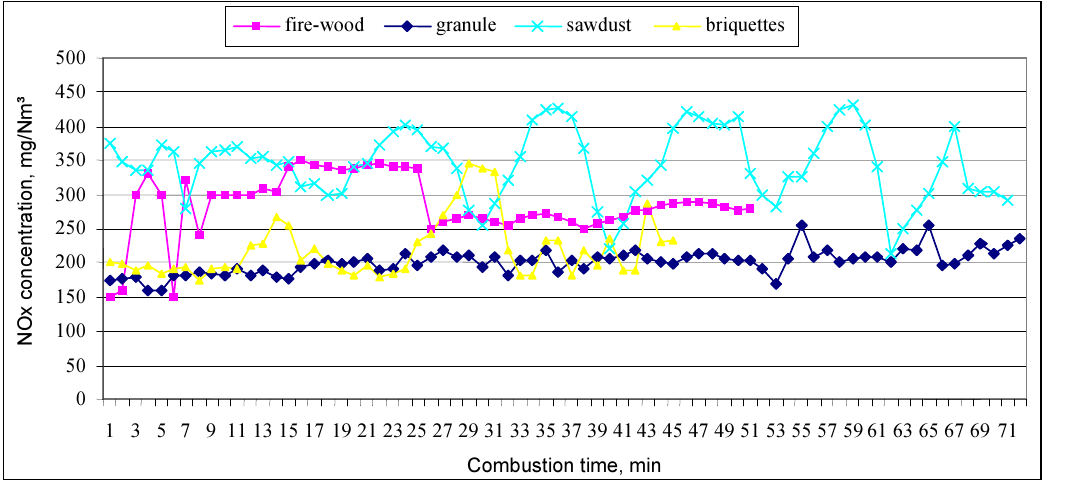
Fig. 8. Concentration of nitrogen oxides in